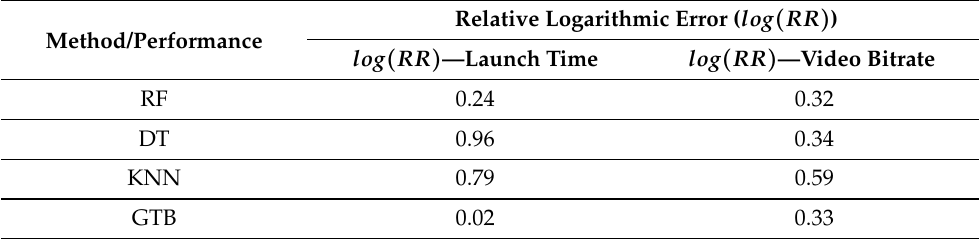
Table 14. Bitrate and launch time prediction performance